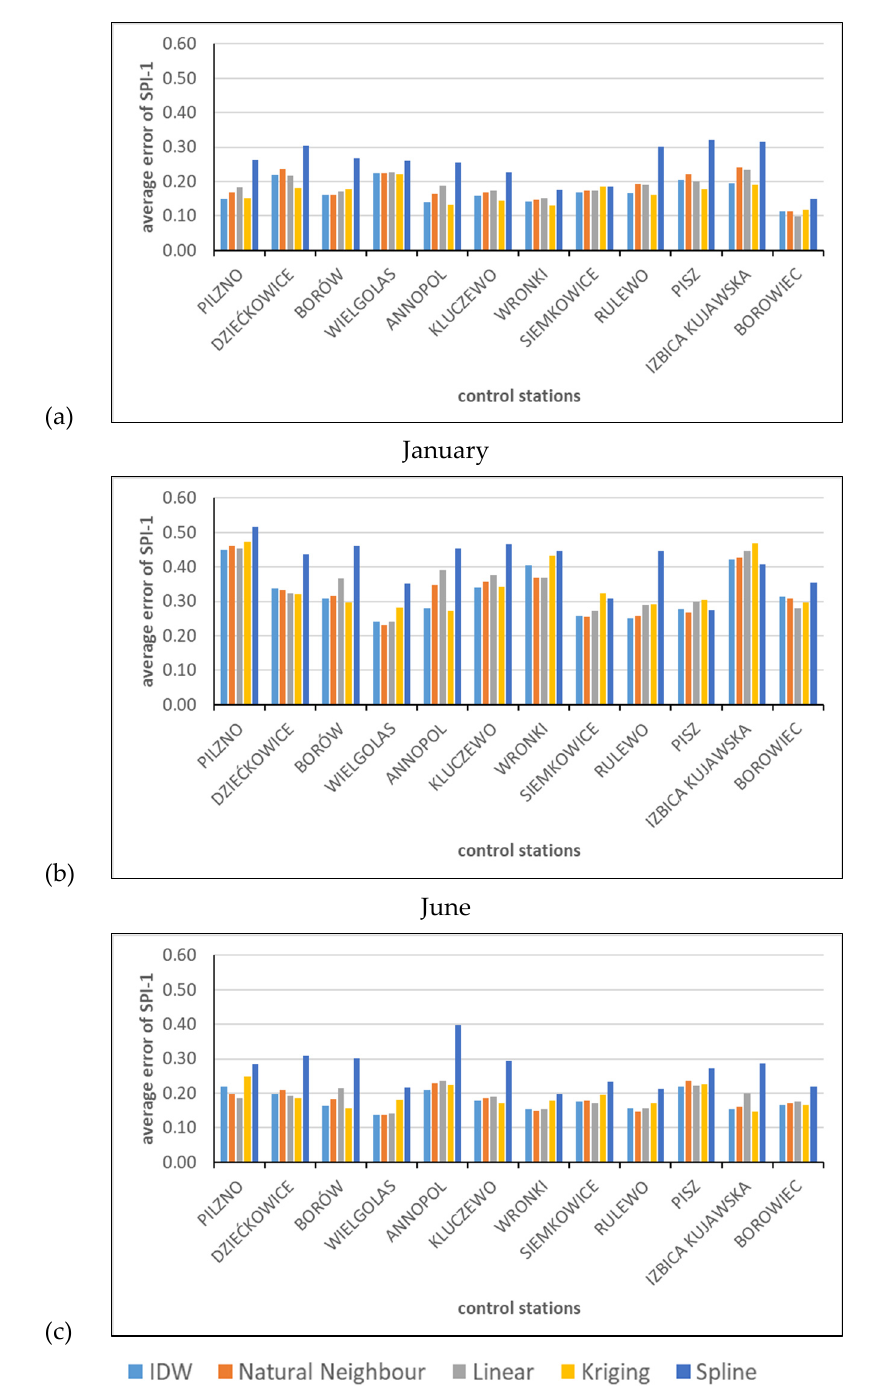
Figure 6. Example of average errors in control stations for ( a ) January, ( b ) June, and ( c )